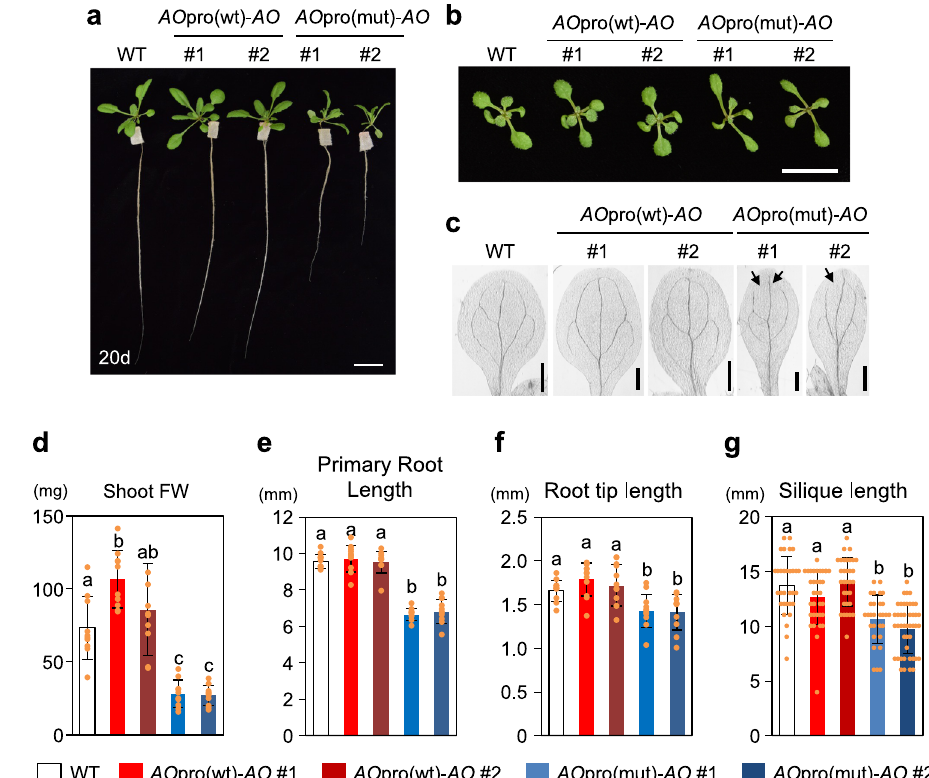
Fig. 4 Phenotypes of AO pro(mut)- AO plants. a Images of shoot and root growth of seedlings grown hydroponically on 1/10MS medium for 20 days. Leaf shapes ( b ) and vascular patterns of cotyledons ( c ) of 10-day-old seedlings grown on agar plates. In ( c ), disconnected points of vascular loops are indicated by arrows. Scale bar = 2 cm ( a ), 1 cm ( b ), and 0.5 mm ( c ). d Fresh shoot weight of 20-day-old seedlings grown hydroponically on 1/10MS medium ( n = 10). e Length of primary roots of 10-day-old seedlings grown on agar plates ( n = 10 – 11). f Length of the meristematic region at the tip of the primary roots of 6-day-old seedlings grown on agar plates ( n = 11 – 12). g Length of all siliques borne on the fi rst fl owering stem of plants grown on nutrient- supplemented soils under the long-day condition ( n > 26). In ( d – g ), data represent mean ± SD, and different letters denote statistically signi fi cant differences (Tukey ’ s honestly signi fi cant difference [HSD] test; P <